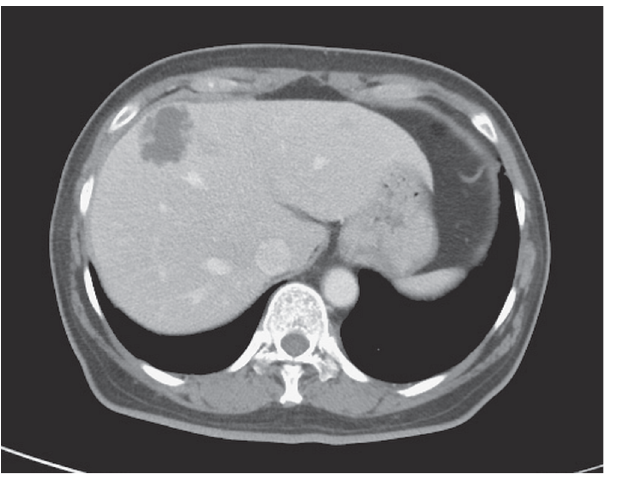
Fig 1. Abdominal CT scan showing a liver